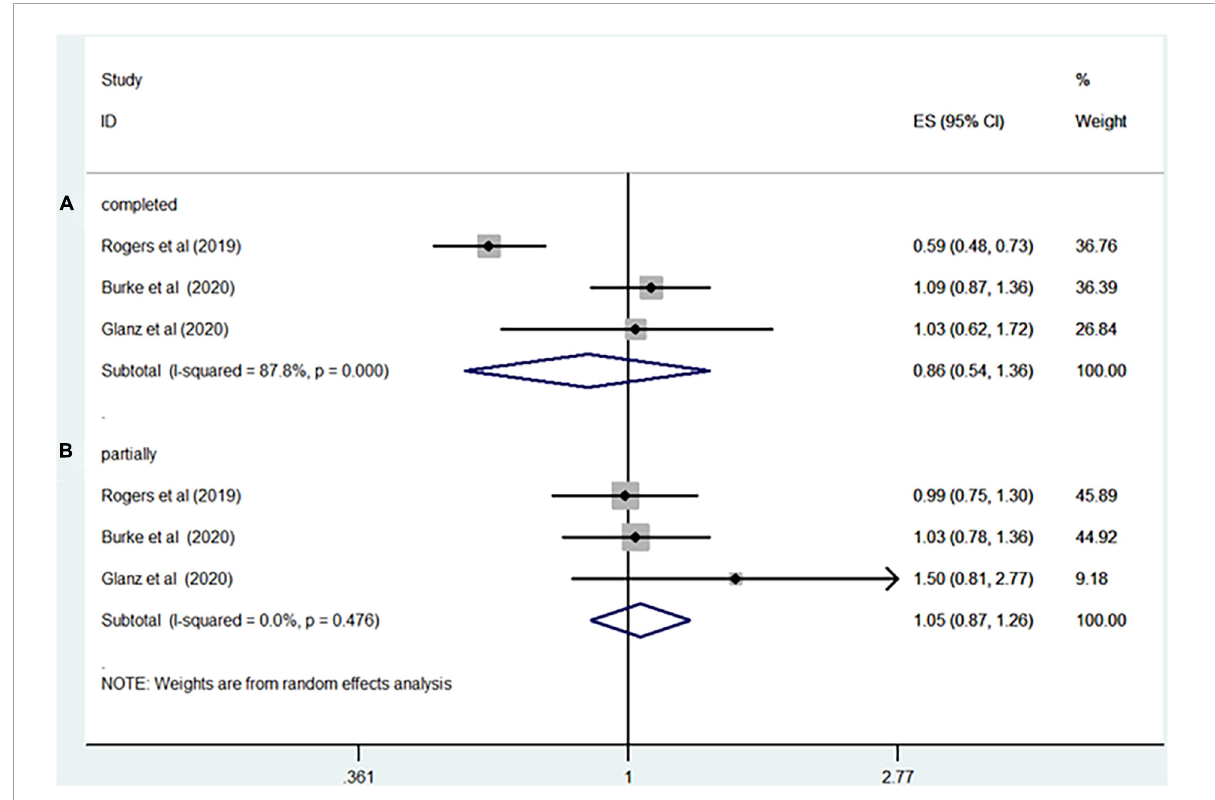
FIGURE3 Rotavirus vaccination exposure and the subsequent risk of T1D (A) complete vaccination (B) partially